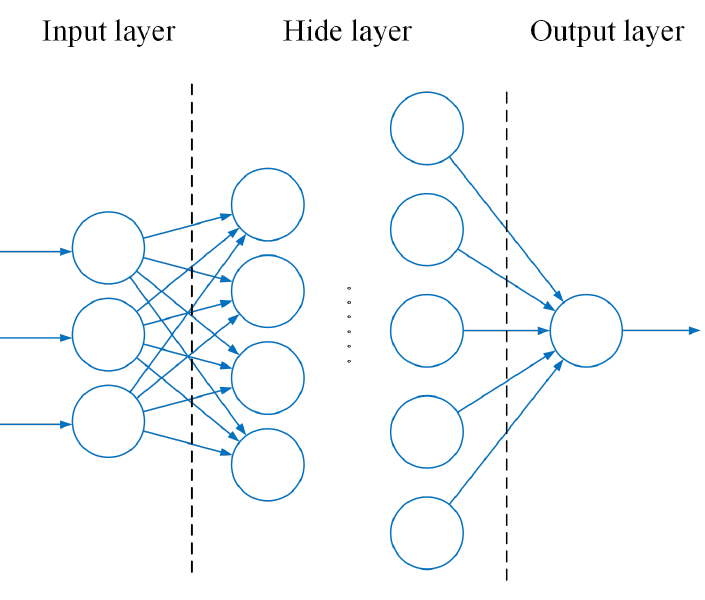
Figure 10. MLP structure